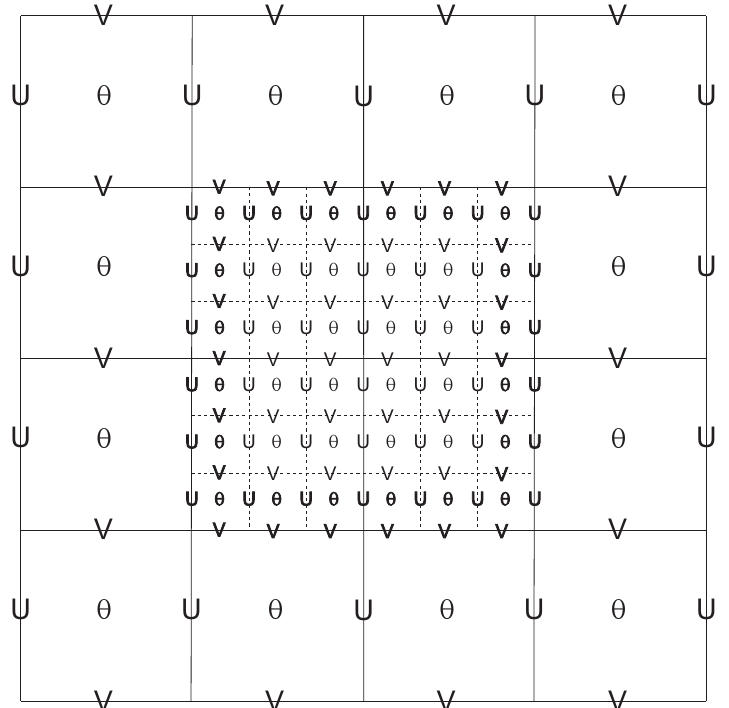
Figure 7.3: Arakawa-C grid staggering for a portion of a parent domain and an imbedded nest domain with a 3:1 grid size ratio. The solid lines denote coarse grid cell boundaries, and the dashed lines are the boundaries for each fine grid cell. The horizontal components of velocity (“U” and “V”) are defined along the normal cell face, and the thermodynamic variables (“ θ ”) are defined at the center of the grid cell (each square). The bold typeface variables along the interface between the coarse and the fine grid define the locations where the specified lateral boundaries for the nest are in